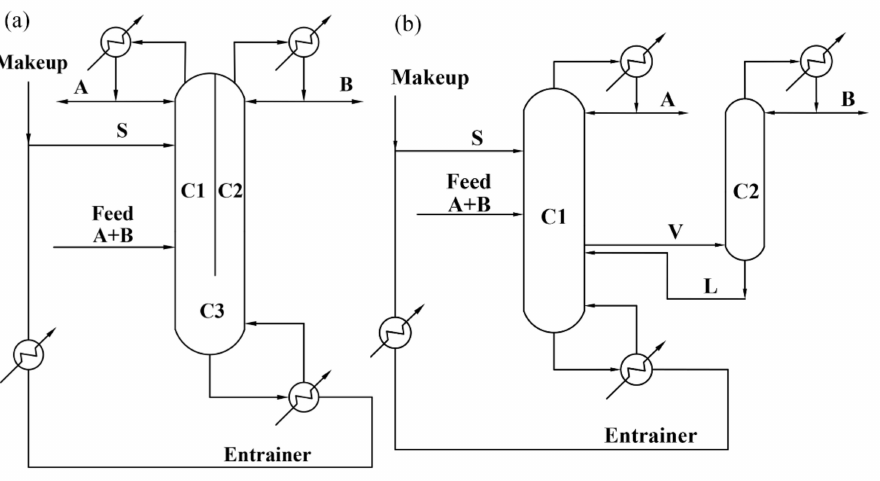
Figure 1. ( a ) Process flowsheet of EDWC and ( b ) equivalent two column model of